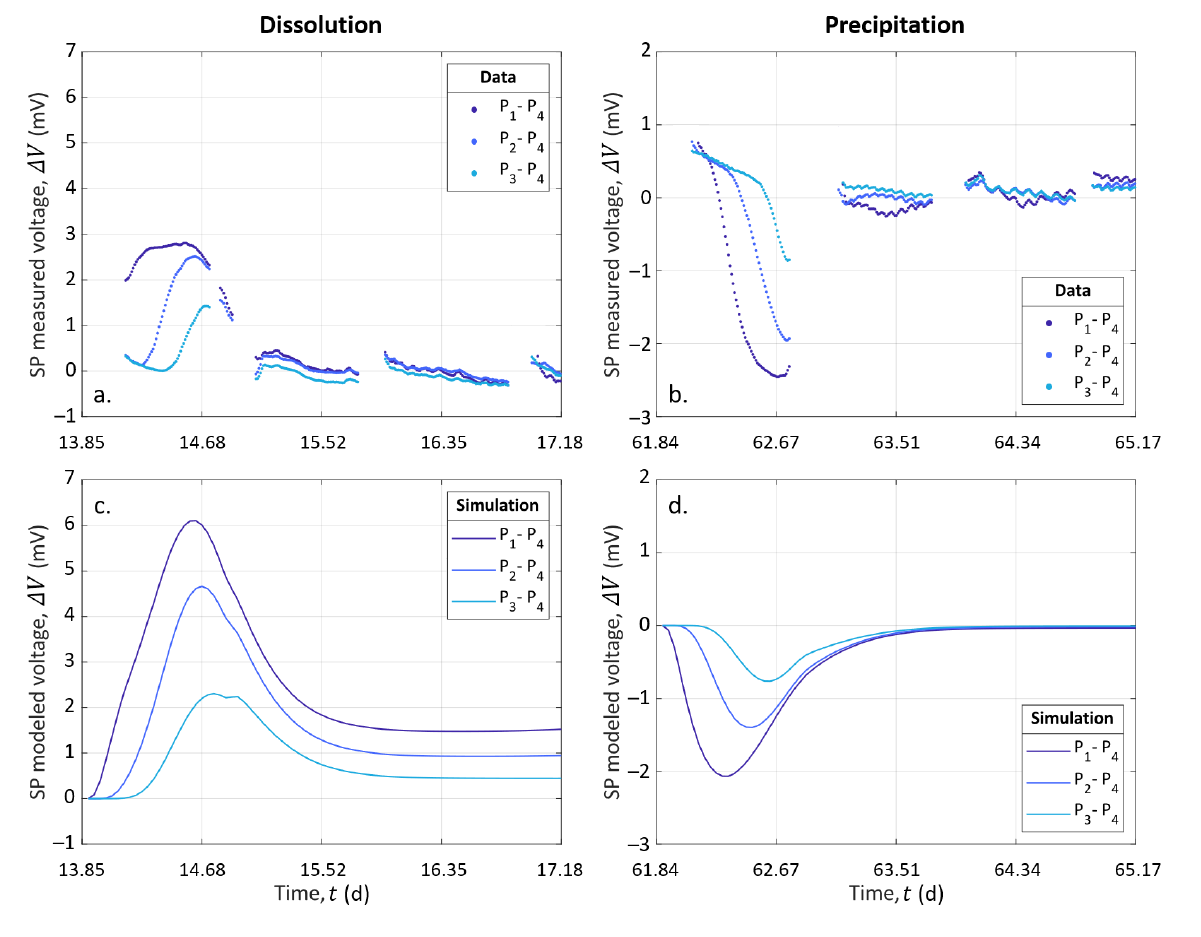
Figure 8. ( a , b ) SP data were corrected from the linear decrease generated by the intrinsic potential drift of the reference electrode P 4 . Time zero corresponds to the timing of Events 2 (injection of solution S1) and 3 (injection of solution S2), respectively. ( c , d ) Electro-diffusive voltage computed from the numerical